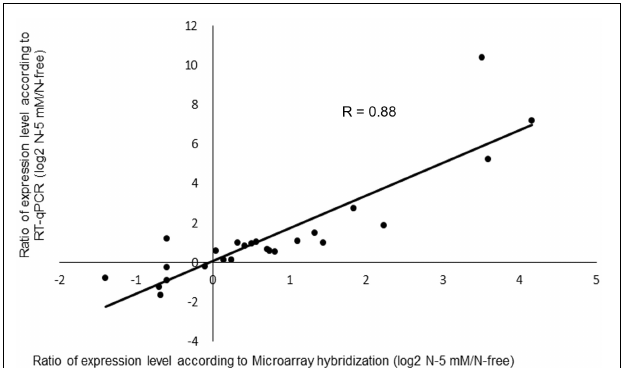
FIGURE 5 | Comparison of differential gene expression in R108 analyzed by microarray hybridization or RT-qPCR. For the experiment, a set of 25 genes, 4 nitrate sentinel genes ( NR1 , NR2 , GS2 , NPF6.7) and 21 randomly selected genes were used ( Supplementary Table 1 ). Log2 ratio of N-5mM/N-free of gene expression determined by RT-qPCR was plotted as a function of the log2 ratio obtained by microarray hybridization.